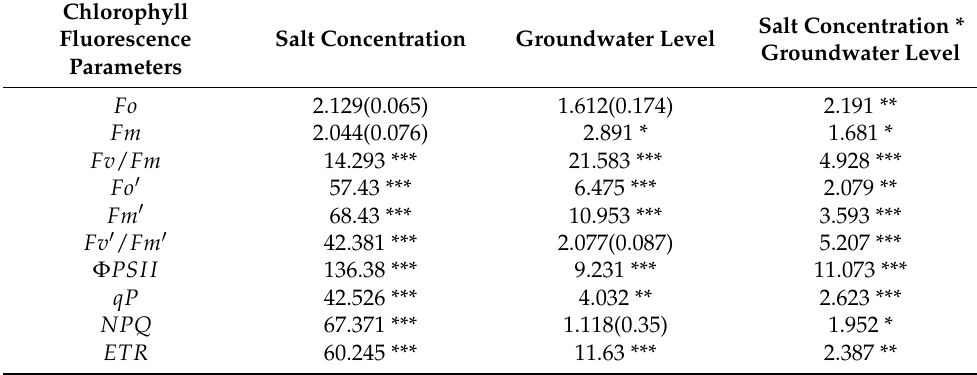
Table 1. Correlations of chlorophyll fluorescence parameters to salinity, groundwater level and their